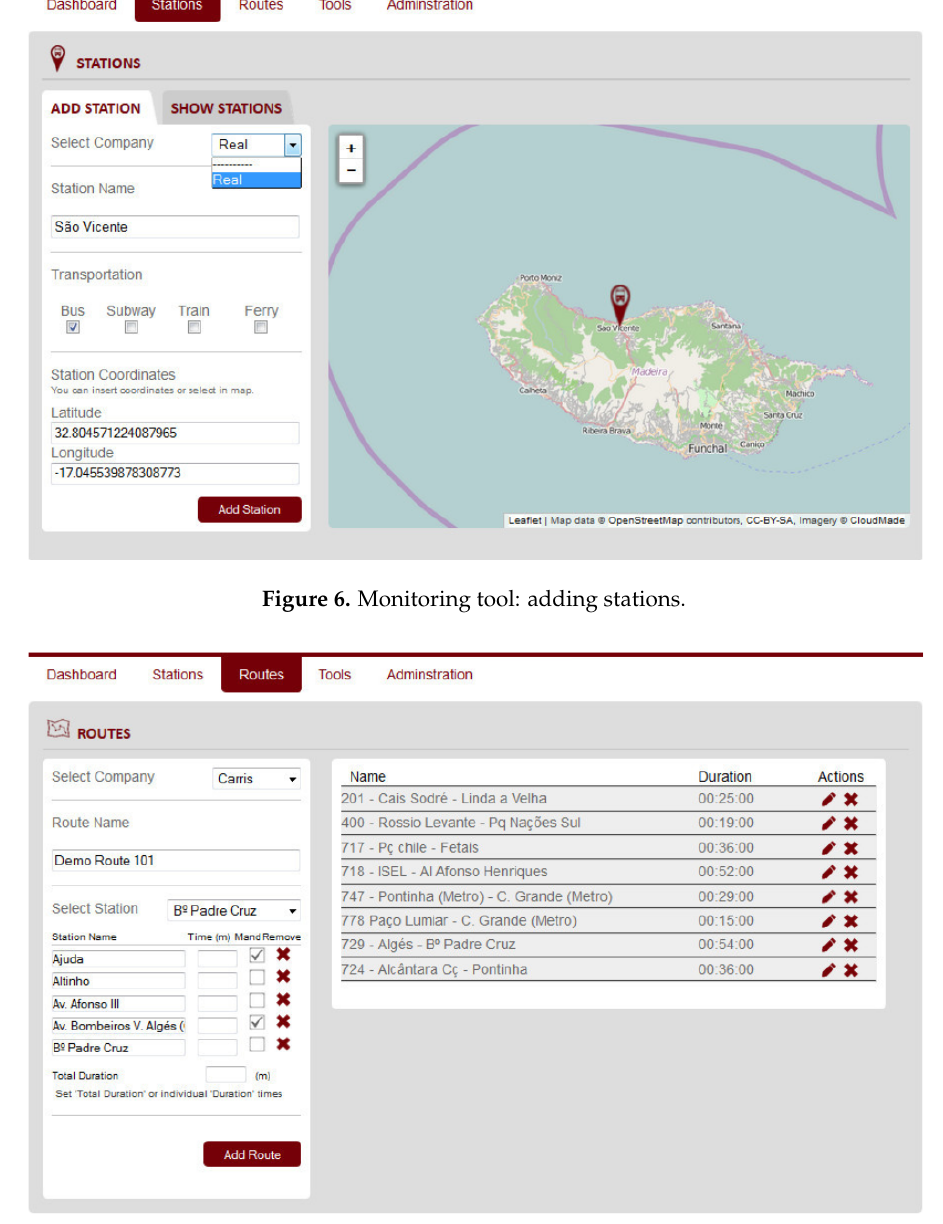
Figure 7. Monitoring tool: adding